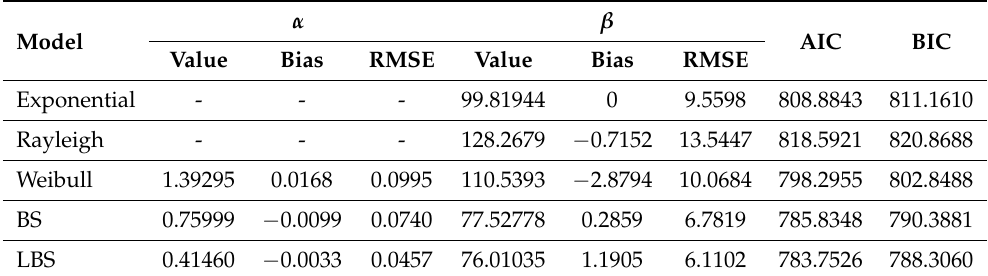
Table 4. Values of MLEs, AIC and BIC of Exponential, Rayleigh, Weibull, BS, LBS and Laplace BS distributions for Cavia Porcellus data.